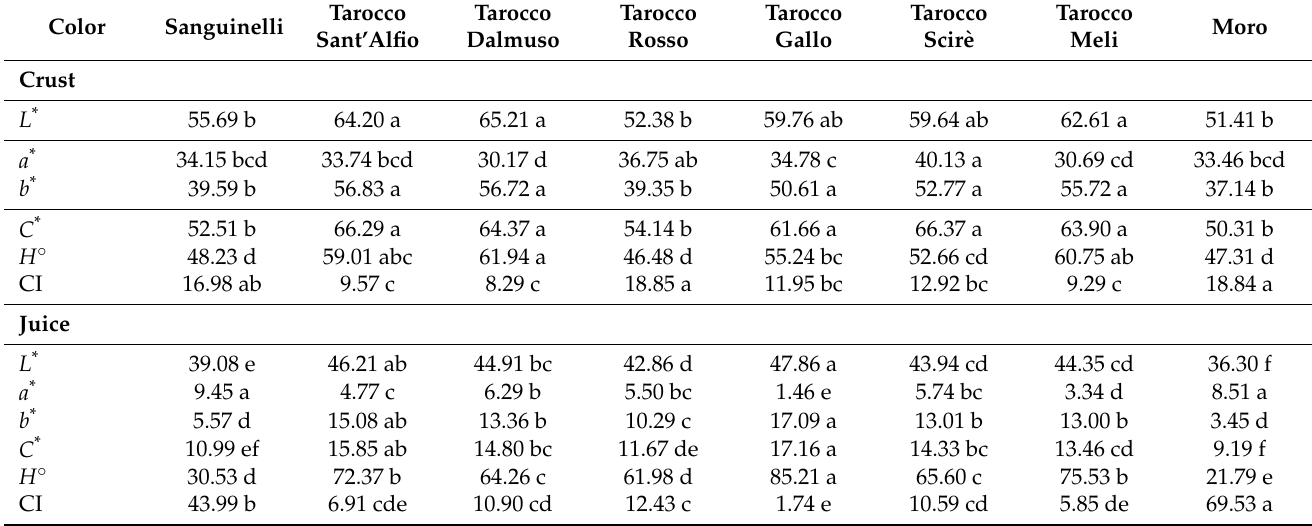
Table 2. Color parameters in crust and juice of eight blood orange varieties (Sanguinelli, Tarocco Sant’Alfio, Tarocco Dalmuso, Tarocco Rosso, Tarocco Gallo, Tarocco Scir è , Tarocco Meli and Moro) grafted on Citrus macrophylla